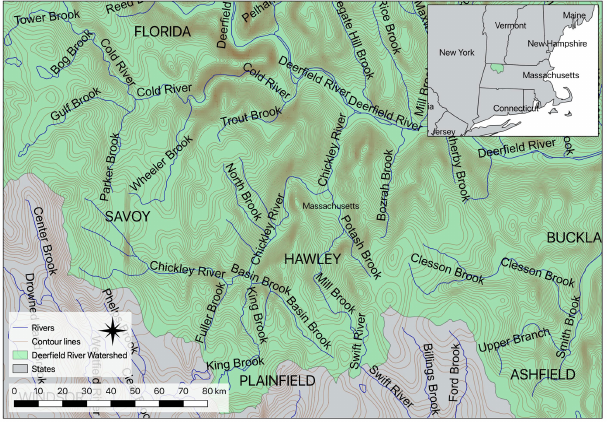
Fig. 1 . Chickley River in the Deerfield River Watershed, part of the Connecticut River Valley, and counties in western Massachusetts,